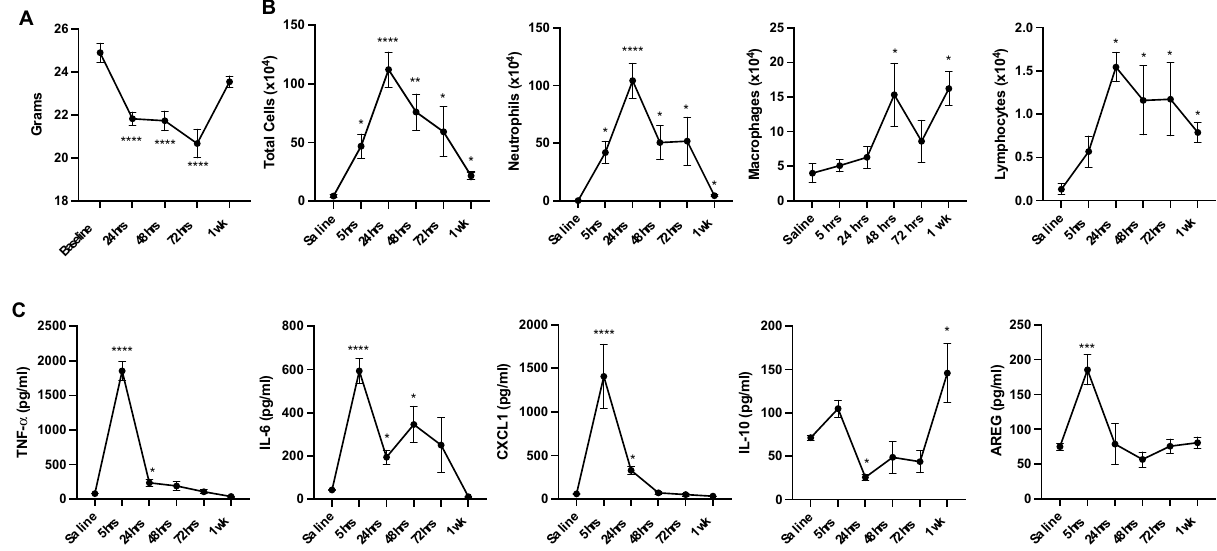
Figure 1. Normal homeostasis recovery trends in airway inflammatory endpoints over time following a one-time inhalation exposure to high-dose LPS. C57BL/6 mice treated once with 100 ug of LPS and allowed to recover without additional treatment up to one week. Line graphs depict mean with SEM bars over time of LPS-induced weight changes ( A ), airway cellular influx ( B ), and levels of pro-inflammatory TNF- ⍺ , IL-6, and CXCL1 (neutrophil chemoattractant), anti-inflammatory (IL-10), and amphiregulin (AREG) from bronchoalveolar lavage fluid (BALF). N = 24 mice (4 mice/time point). Statistical significance denoted versus saline/baseline as *p < 0.05, **p < 0.01, ***p < 0.001, ****p <